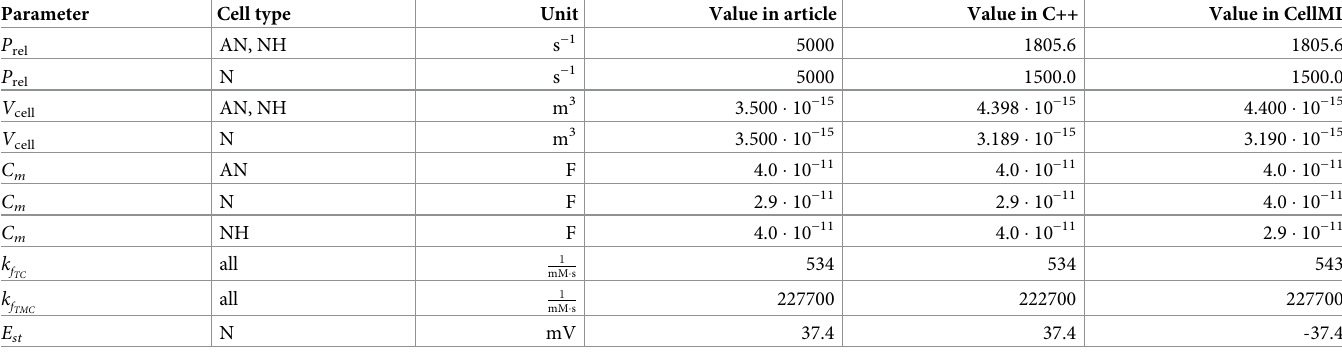
Table 3. Parameter values that differ between the published article and the C++ and CellML implementations.